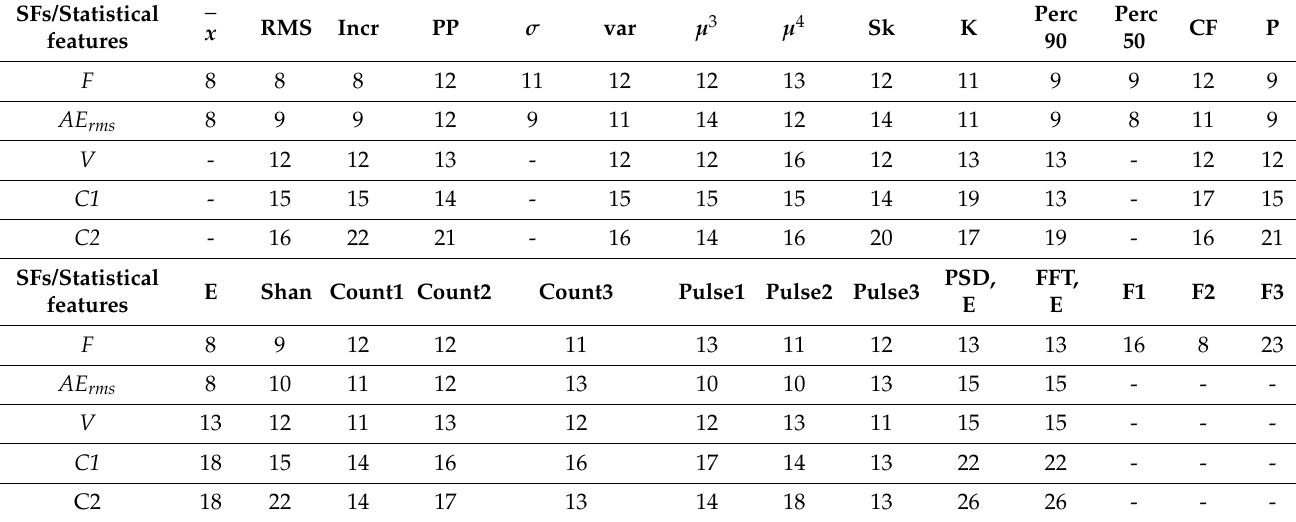
Table 5. The minimum value of RMSE (L) for individual